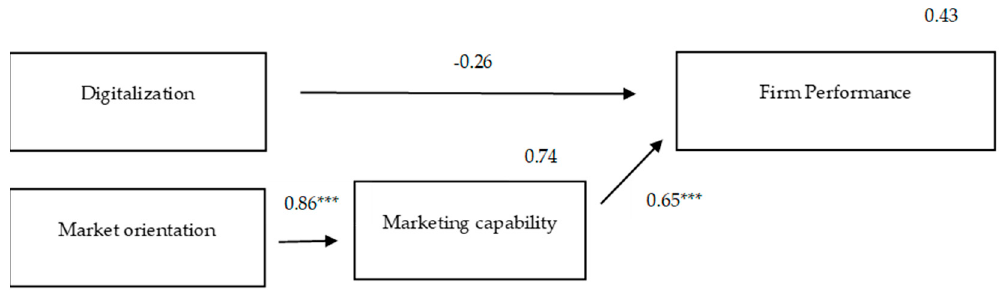
Figure 2. Standardized values for the tested model with internationalized firms. *** indicates significance at the 99% level, respectively.